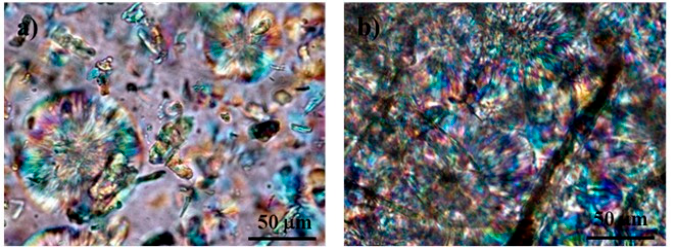
Figure 10. Polarized optical microscopy images of: ( a ) PLA/MCC and ( b ) PLA/UP biocomposite films (see Table 1 for sample identification).